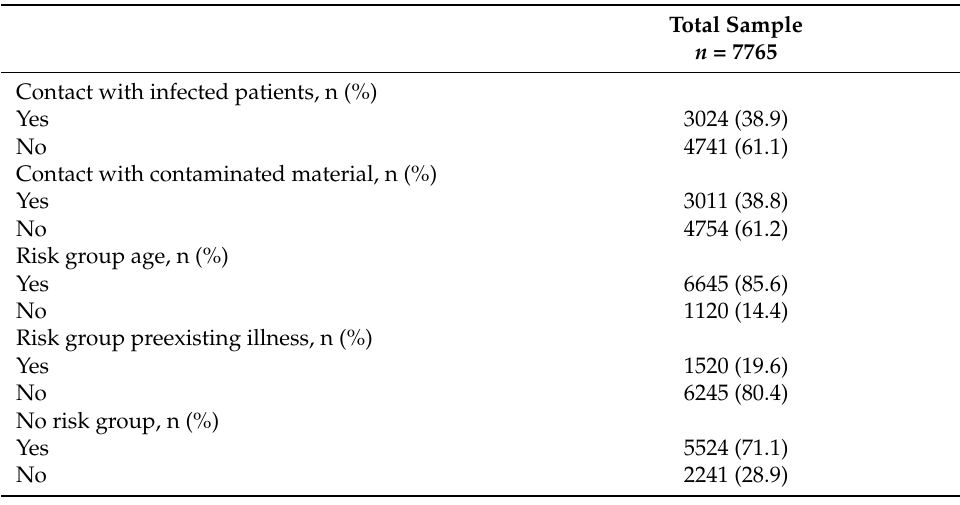
Table 2. COVID-19 related characteristics of the study